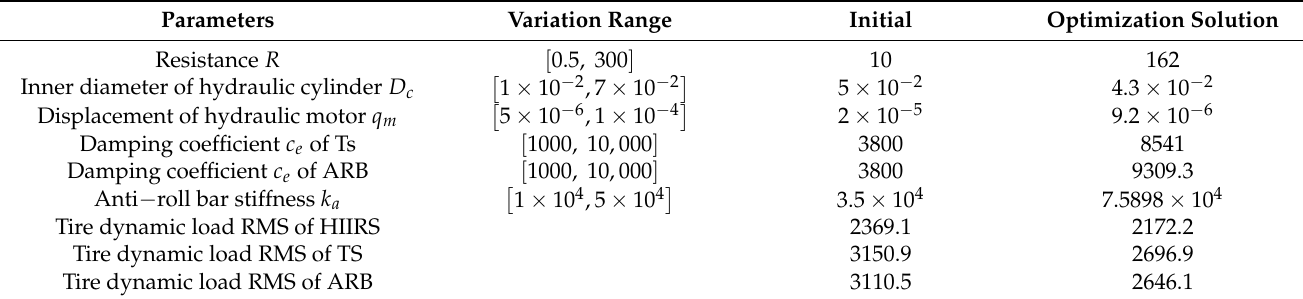
Table 6. Road holding optimization